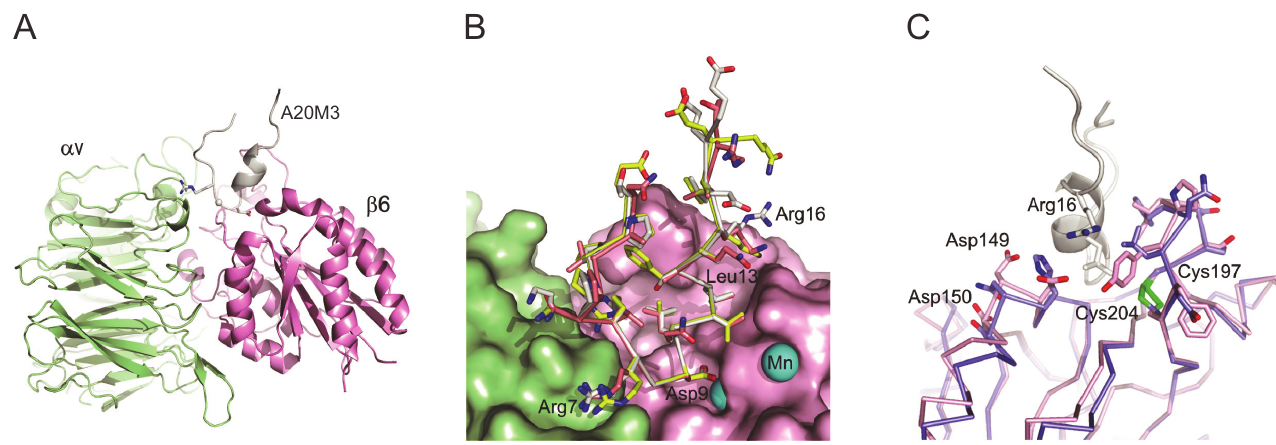
Fig 8. Molecular docking simulations of FK-M1 and FK-M3 RGD-containing peptides with mouse α v β 6 and α v β 8 integrins. (A) Overview of α v β 6 complexed with the 20mer A20M3 peptide. α v (light green), β 6 (pink) and A20M3 (grey) chains are shown as cartoon traces. Side chains of the RGD motif are shown as sticks and spheres. (B) Superposition of α v β 6 in surface representation in complex with A20M1 (yellow carbons), A20M3 (grey carbons) and A20FMDV2 (salmon carbons). The position of manganese ions (cyan spheres) shown superimposed were derived from the human α v β 6/TGF β 1complex (PDB ID: 5ffo). Labeled aa refer to the A20M3 sequence. (C) Superposition of the α v β 6/A20M3 complex onto the α v β 8 structure (blue carbons). Note that the A20M3 peptide is not shown here. Residue numbering refers to the Uniprot entry Q9Z0T9 (mouse integrin subunit β 6) and the A20M3 peptide sequence (Arg16).